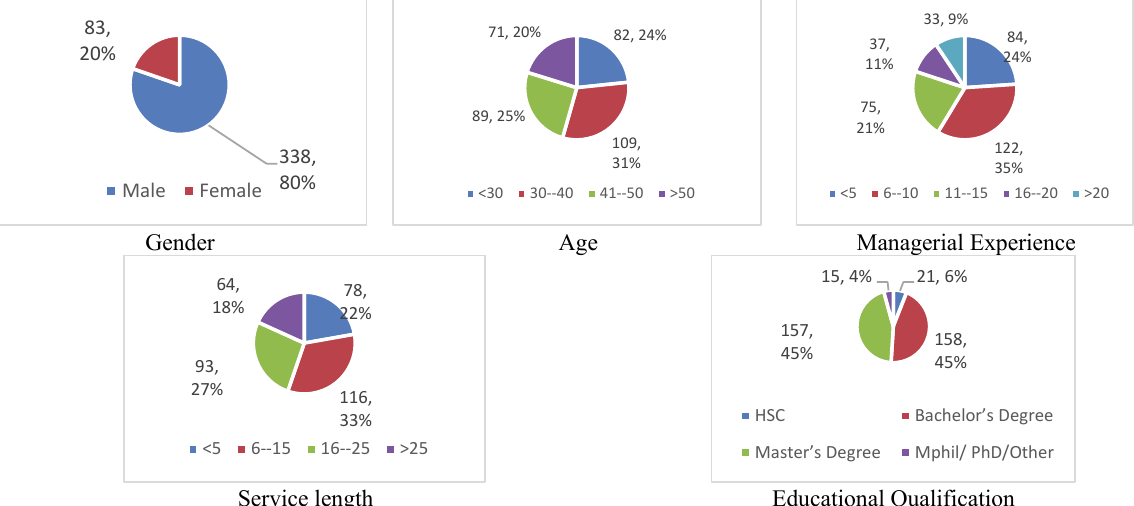
Fig. 2. Describing the sample's personal and demographic variables